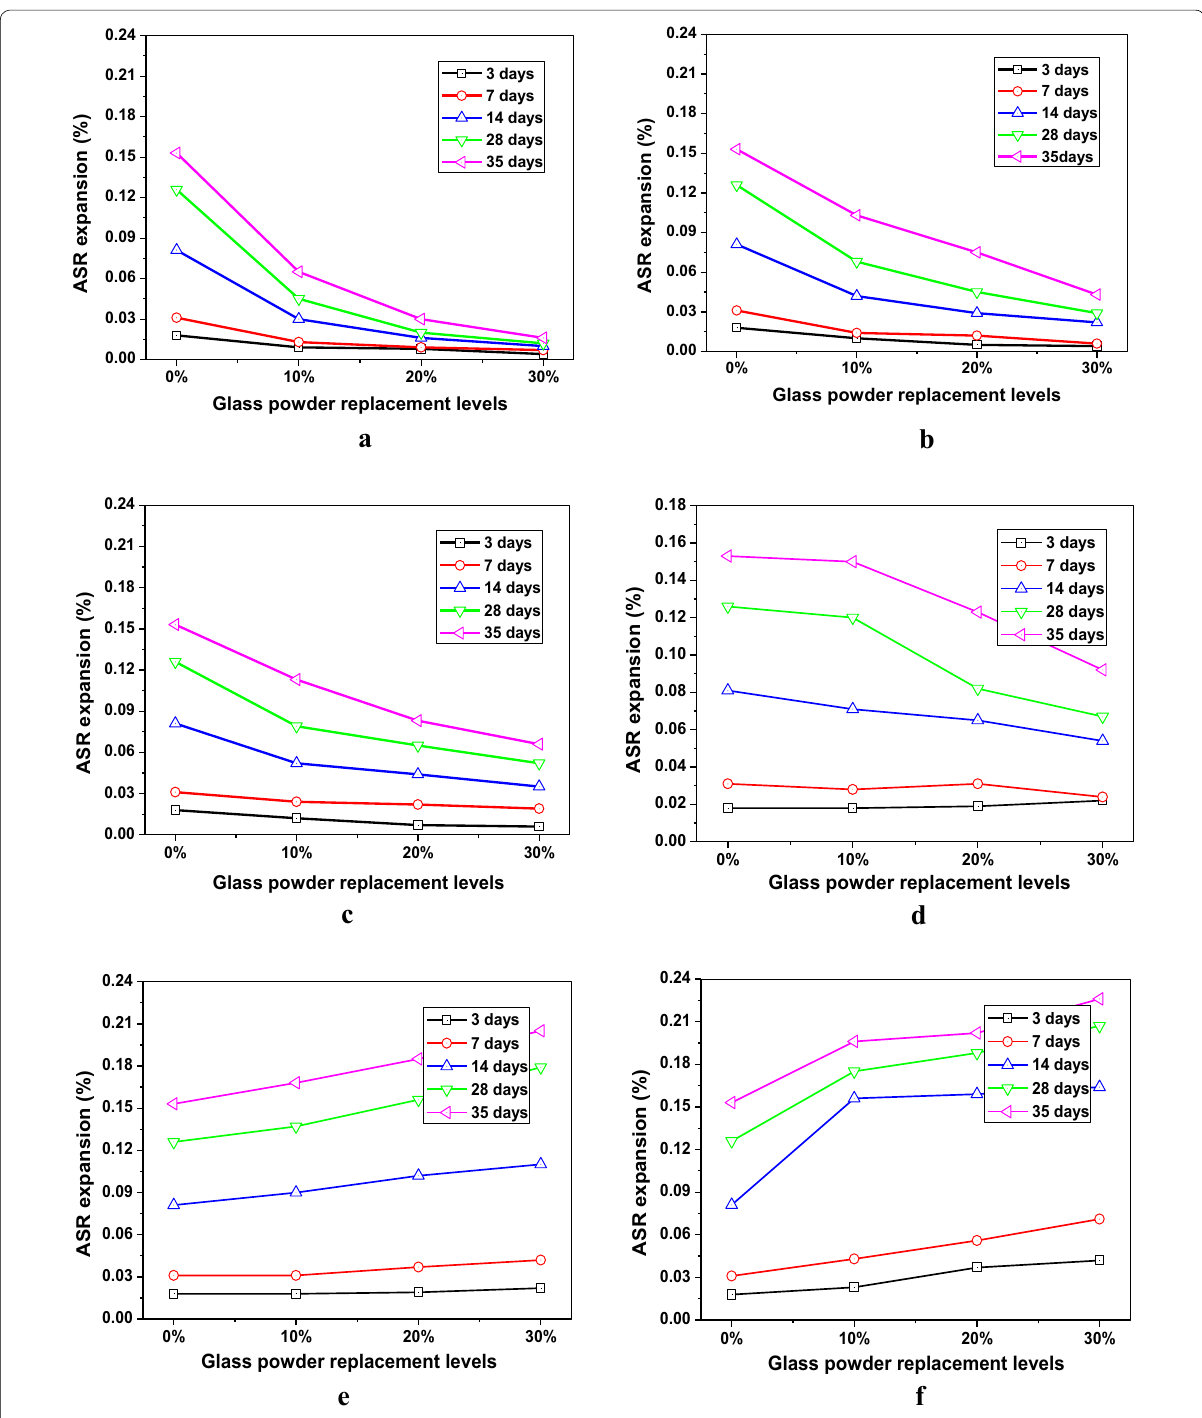
Fig. 3 Effect of the content of glass powder on ASR expansion of cement mortar bars with different particle sizes. a Particle size ranging from 38 to 53 μm, b particle size ranging from 53 to 75 μm, c particle size ranging from 75 to 150 μm, d particle size ranging from 150 to 300 μm, e particle size ranging from 300 to 600 μm, f particle size ranging from 600 to 900